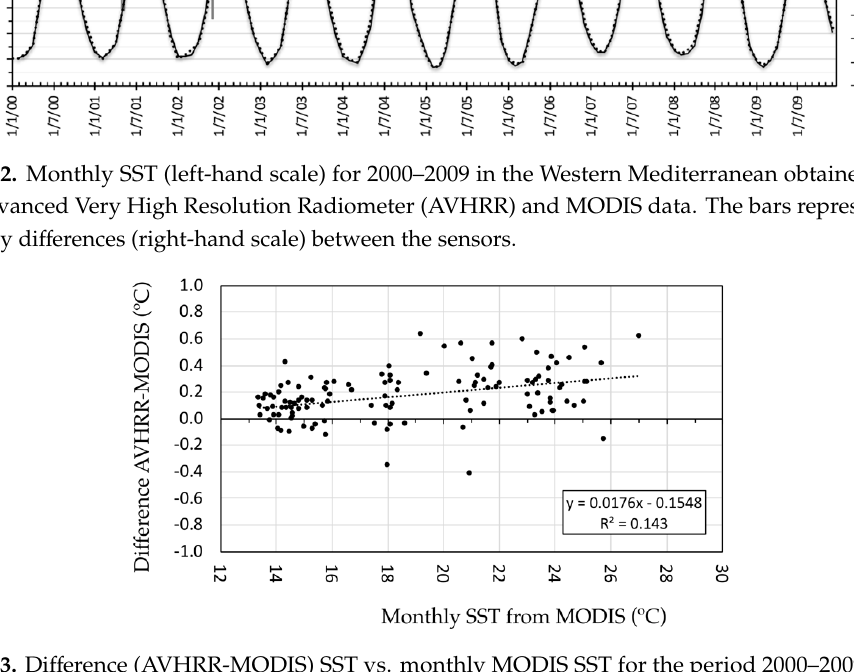
Figure 3. Difference (AVHRR-MODIS) SST vs. monthly MODIS SST for the period 2000–2009 in the Western Mediterranean. Positive values indicate that AVHRR SST are higher than MODIS SST and negative values indicate the contrary. A slight trend towards higher bias at higher temperatures was observed but the correlation was weak (R 2 = 0.143).